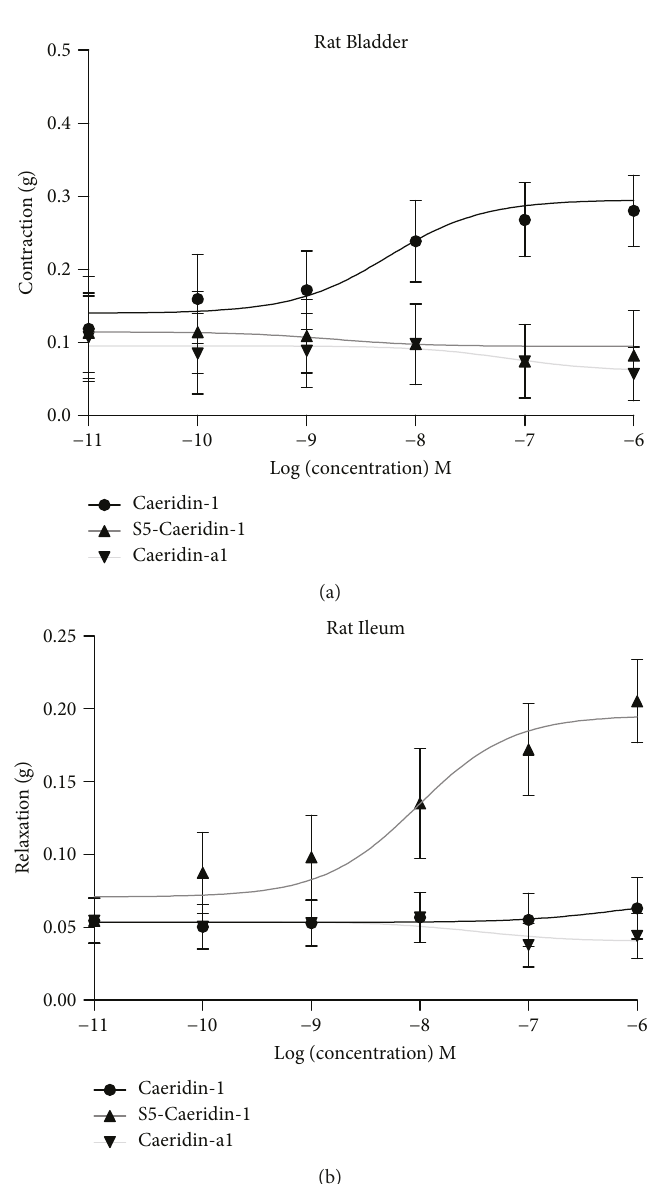
Figure 7: Dose-response curves of (a) synthetic Caeridins using rat urinary bladder smooth muscle preparations and (b) synthetic Caeridins on rat ileum smooth muscle preparations. Each point represents the mean and standard error of mean (SEM) of 5